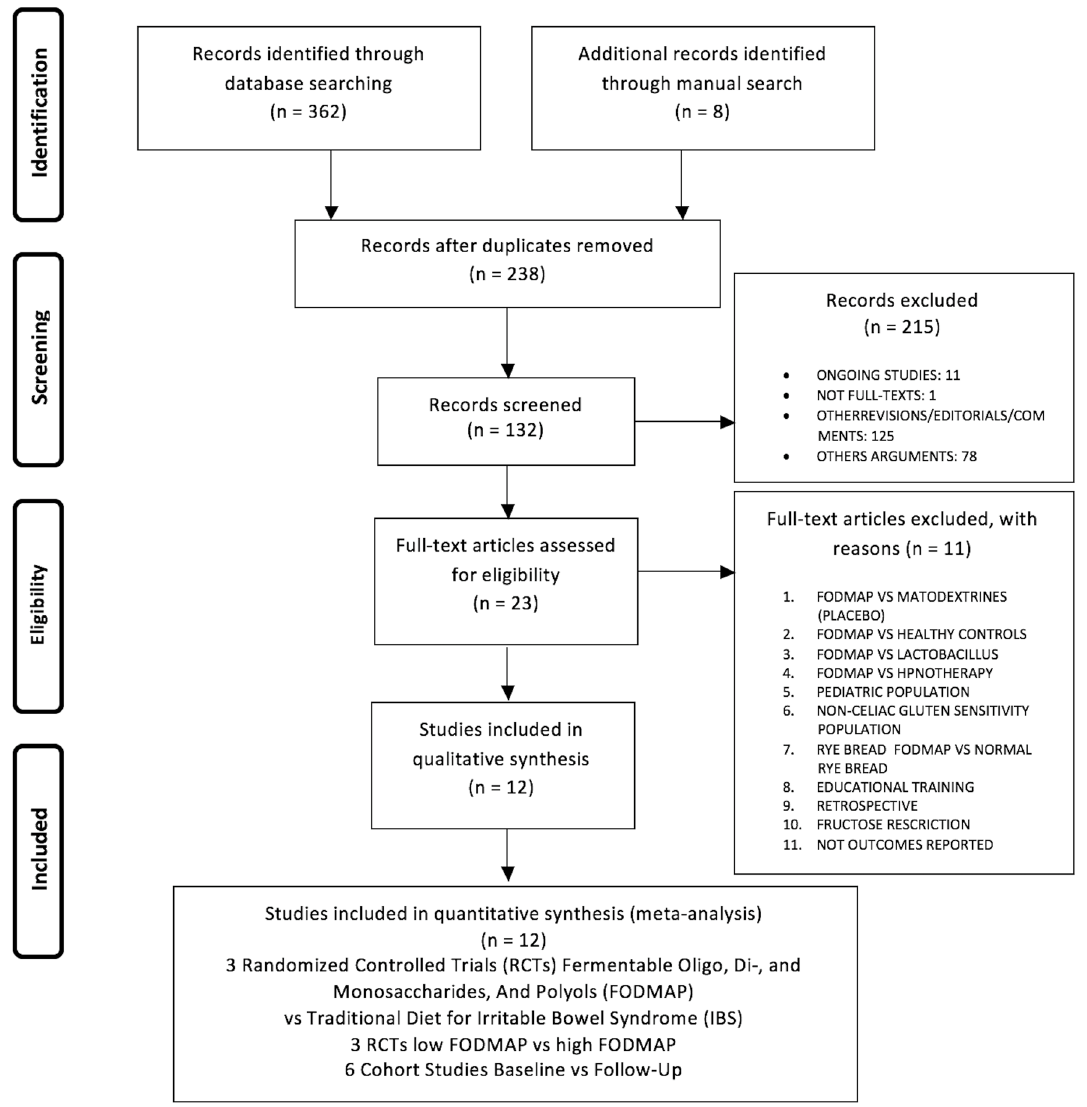
Figure 1. Flow chart search strategy.